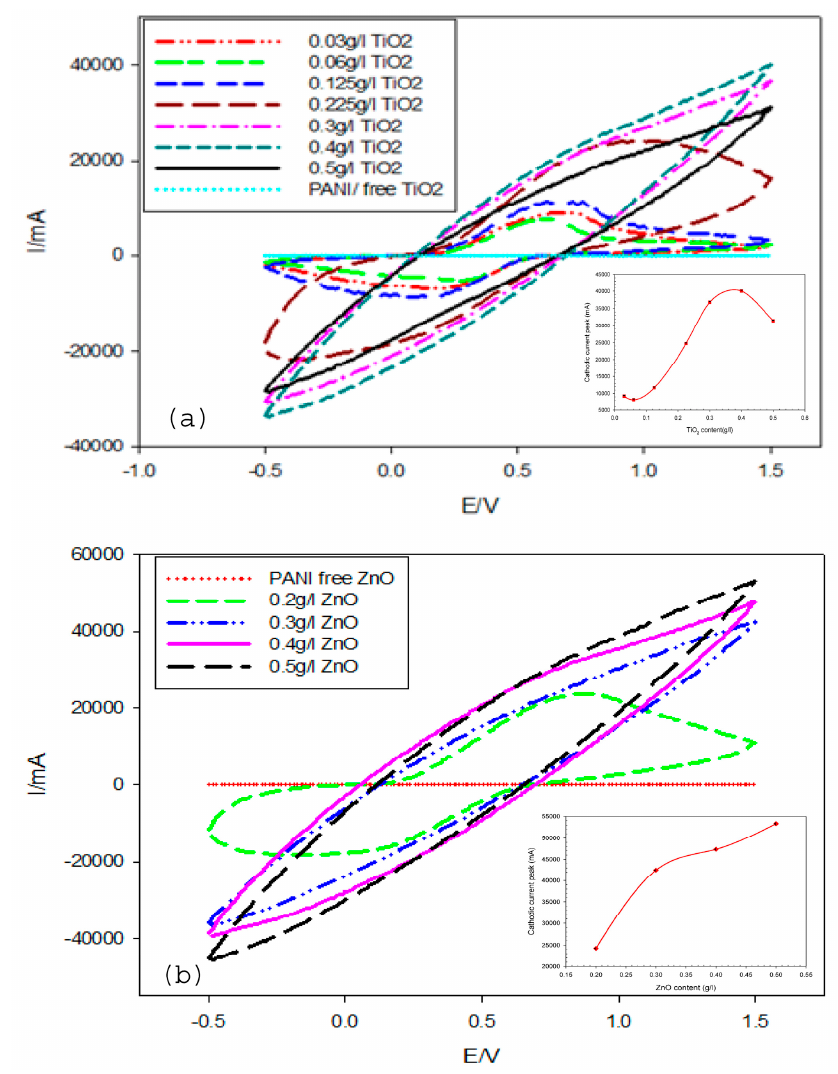
Figure 10. Cyclic voltammograms of PANI / TiO 2 nanocomposite ( a ) and PANI / ZnO nanocomposite ( b ) at 30 cycles in 0.5 M H 2 SO 4 .